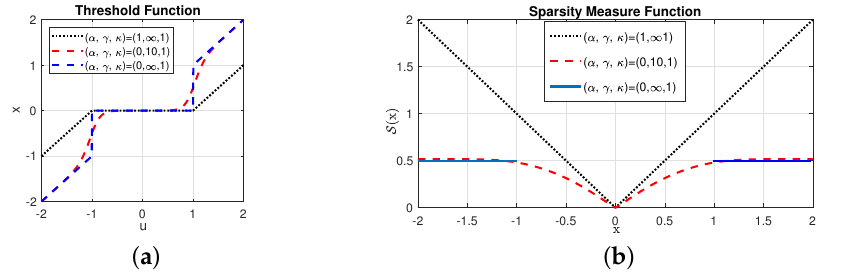
Figure 1. Threshold function and sparsity measure function. ( a ) The shape of T α , γ , κ ( u i ) under various settings. ( b ) Sparsity measure function. For α = 0, γ → ∞ and κ = 1, the value of x cannot be in the range of ( 0,1 ) based on the property of the ideal thresholding function T 0, ∞ ,1 ( u )